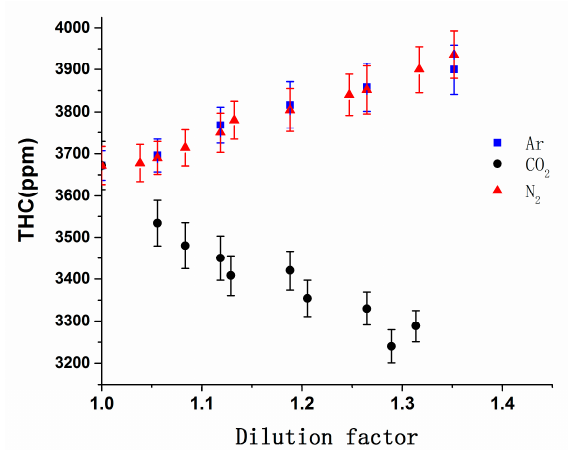
Figure 13. Variation in THC emissions vs. the DF of CO 2 , N 2 , and Ar.